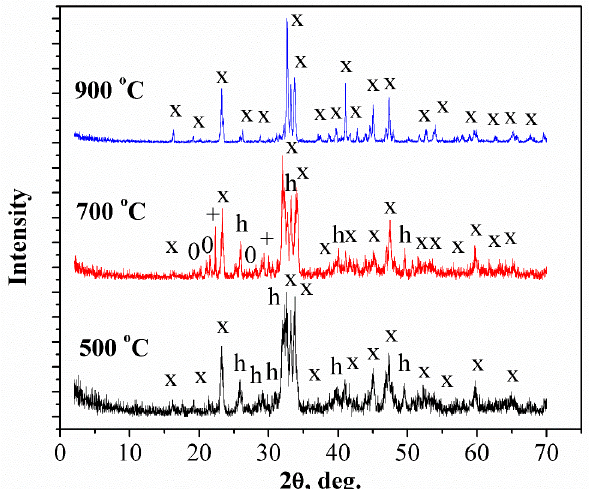
Figure 4. The XRD of ceramic samples based on cement-salt stone prepared from powder mixture of calcium citrate tetrahydrate and sodium dihydrogen phosphate in the temperature range of 500– 900 °C. x— β -CaNaPO 4 (PDF 29-1193); h—Ca 10 (PO 4 ) 6 (OH) 2 (PDF 74-565); +— β -Ca 3 (PO 4 ) 2 (PDF 9-169); 0—CaNa 2 P 2 O 7 (PDF 48-557)